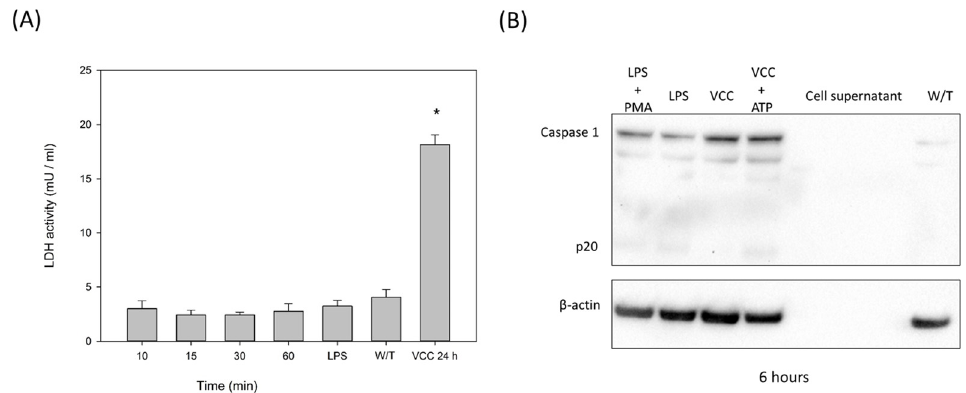
Figure 7. The VCC initiates the expression of the transcription factor NF- κ B. ( A ) THP-1 cells were exposed to VCC (0, 10, 15, 30, 60 min and 24 h); the LDH activity was detected and determined from the collected conditioned media. Data are the mean ± SD from three independent experiments. W/T, without treatment. * p < 0.001 (ANOVA plus the Student–Newman–Keuls method). ( B ) Expression of Caspase-1 protein with different treatments (LPS and PMA, LPS, VCC, VCC + ATP) at 6 h was measured by a western blot assay. The β -actin protein level is shown as the internal control.